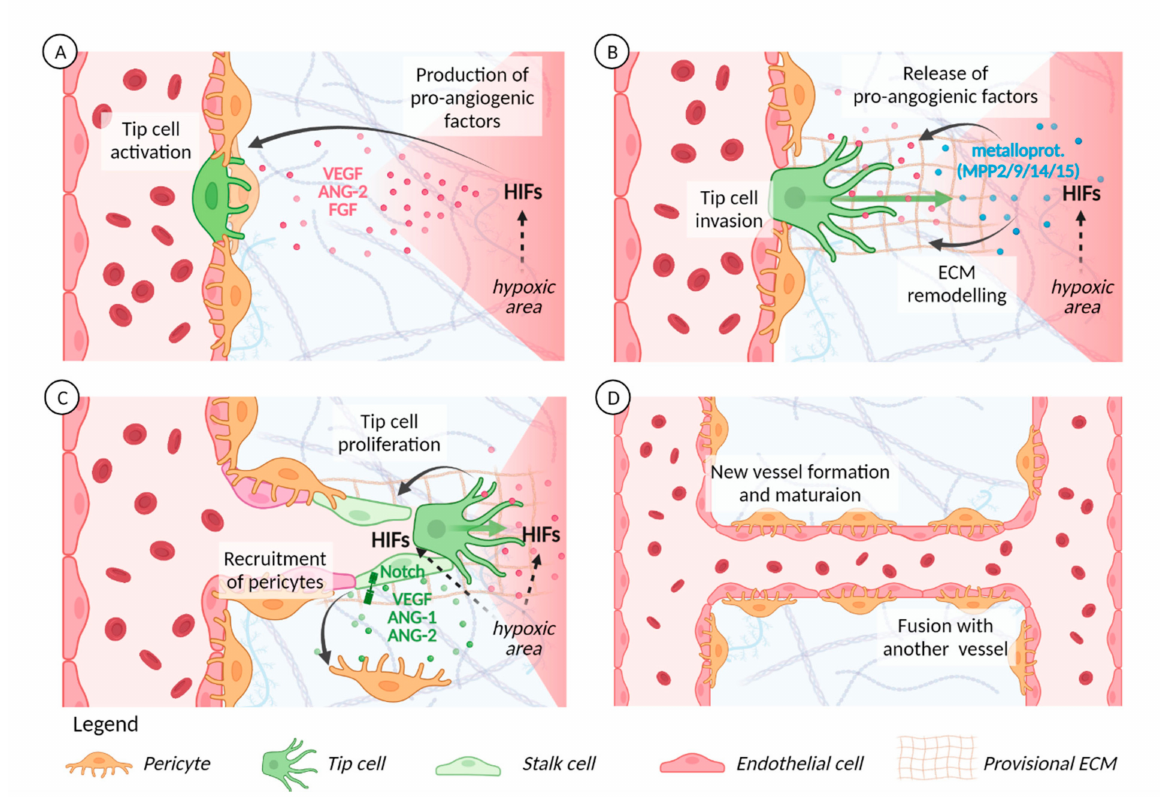
Figure 2. Sprouting angiogenesis is related to hypoxic signaling: ( A ) Cells under hypoxic conditions release angiogenic fac- tors that help loosen the pericytes, resulting in unstable vessels and activation of VEGFR2-expressing tip cells. ( B ) Pericytes detach, EC becomes hyper-permeable in response to VEGF [37], metalloproteases extravasate to degrade the ECM causing release of stored growth factors and proenzymes. A new, provisional ECM is made. Endothelial cells start invading the provisional ECM [116]. ( C ) Hypoxia establishes Tip/Stalk cells. Tip cells are highly mobile, while stalk cells are immotile and proliferative, enabling pericyte recruitment while the branch extends towards hypoxic signals [117]. Pericyte recruitment stabilizes the vessel. Furthermore, cells in the termination area release Vasohibin1, leading to angiogenesis inhibition and vessel stabilization [112]. ( D ) The angiogenic vessel fuses with another vessel. Oxygenated blood circulates through the lumen, dampening the hypoxic signals. Mesenchymal cells migrate along the vessel and form mature pericytes, stabilizing the vessel and helping it mature